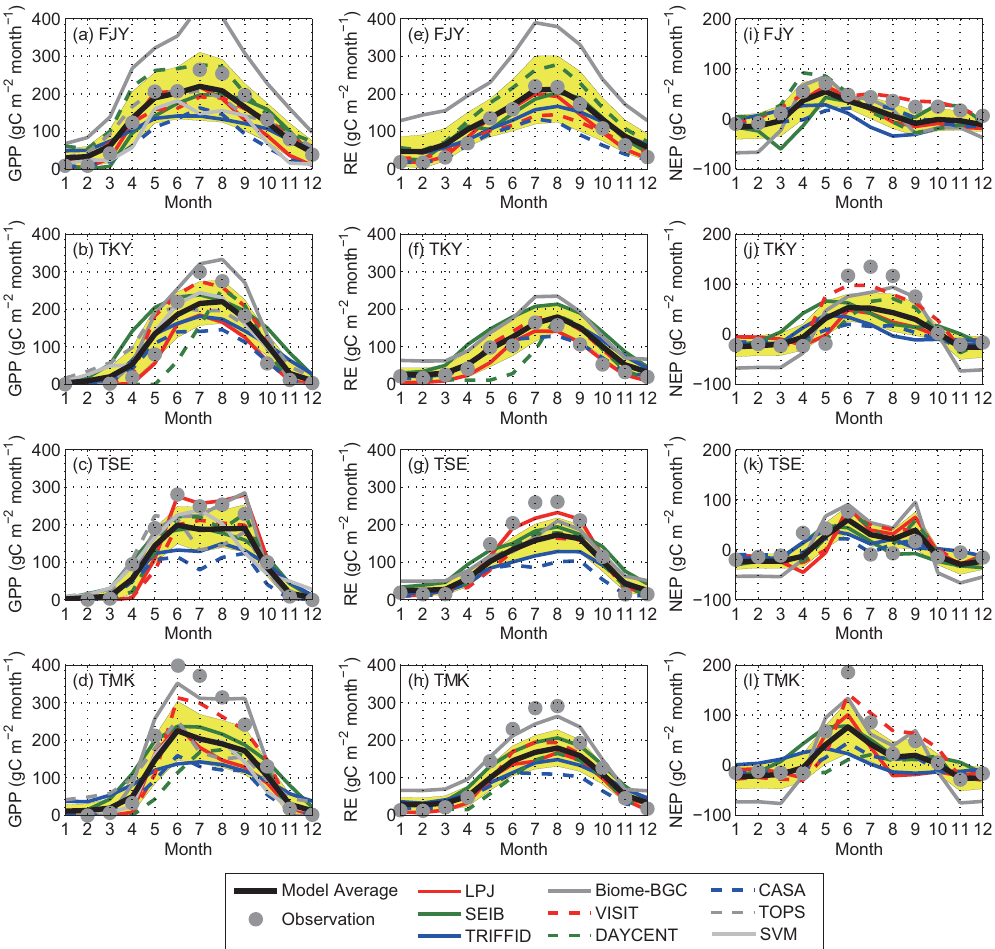
Fig. 2. Seasonal variations in GPP, RE, and NEP at four eddy flux sites from nine models (colored lines) and from observations (gray circle). Default models were used for the simulation. The model average (black bold) and the average ± standard deviations for the models (yellow) are also